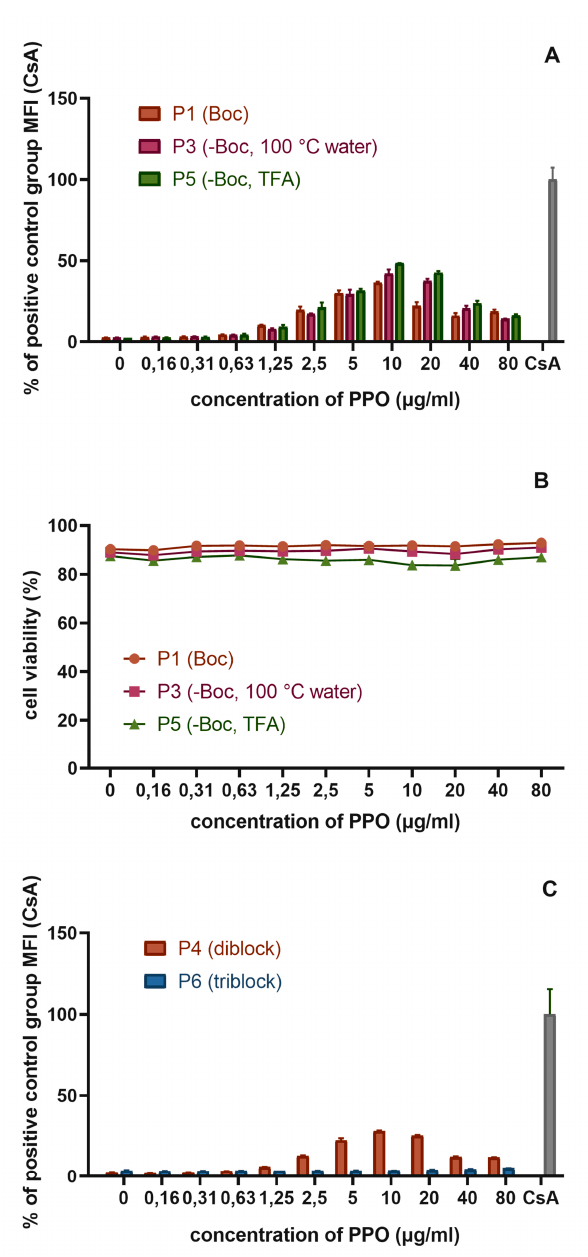
Figure 6. The inhibitory activity of block copolymer carriers in P388/MDR cells determined by calcein efflux assay. ( A ) The influence of Boc-deprotection on P-gp inhibition in P388/MDR cells after 24 h of cultivation (5% CO 2 , 37 °C) with titrated concentrations of block copolymers containing indicated amount of PPO; 10 µM cyclosporine A as the positive control; ( B ) The effect of micelle-forming copolymers on viability of P388 / MDR cells determined using Hoechst 33258. Cell viability after 24 h of cultivation with Boc-protected and or Boc-deprotected copolymers; ( C ) The ability of Boc-deprotected diblock P4 and triblock P6 copolymers to inhibit P-gp